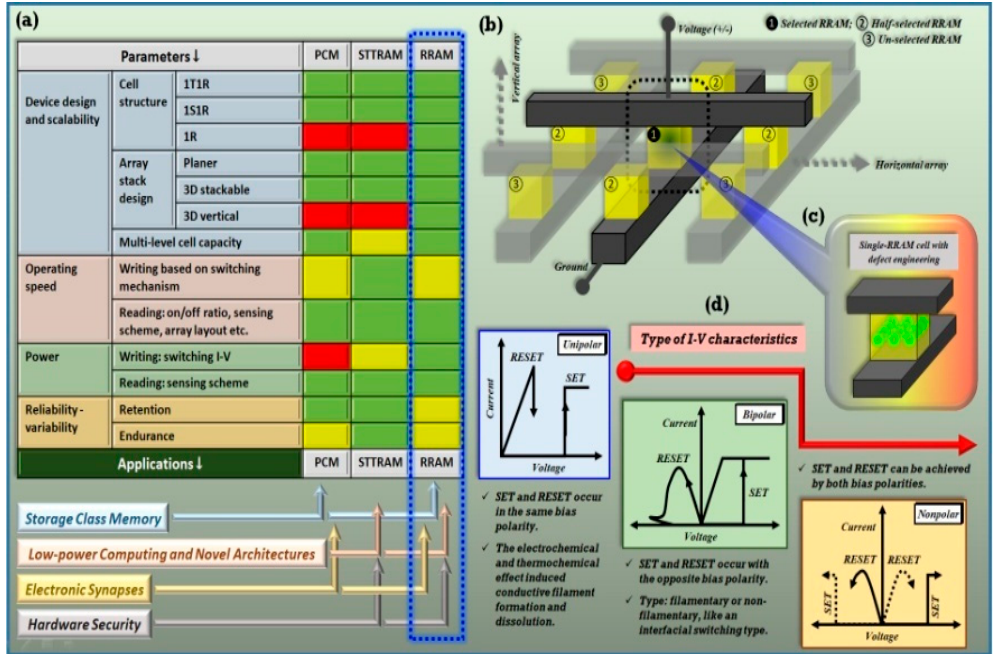
Figure 8. ( a ) Illustration of major emerging nonvolatile memory devices and applications. Major emerging NVM devices are PCM, STT-RAM, and RRAM; however, the PCM and STTRAM technologies are also considered as prototype memory. Among those alternatives, RRAM is a promising candidate in the field of memory, novel architecture, neuromorphic computing, and in security. ( b ) Schematic of a 3 × 3 array of cross-bar RRAM devices, with ① selected one under biasing condition only, ② half-selected cells, and ③ unselected cells. ( c ) A single RRAM cell also can be constructed with defect engineering. ( d ) The general I–V characteristics of RRAM cells.